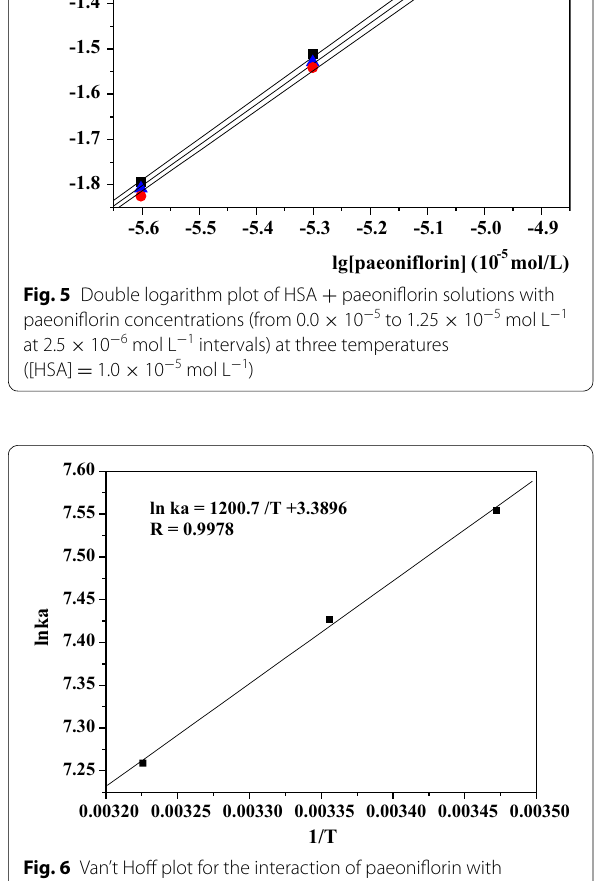
Fig. 6 Van’t Hoff plot for the interaction of paeoniflorin with HSA with paeoniflorin concentrations (from 0.0 10 − 5 to × 1.25 10 − 5 mol L − 1 at 2.5 10 − 6 mol L − 1 intervals) at three tem‑ × × peratures ([HSA]